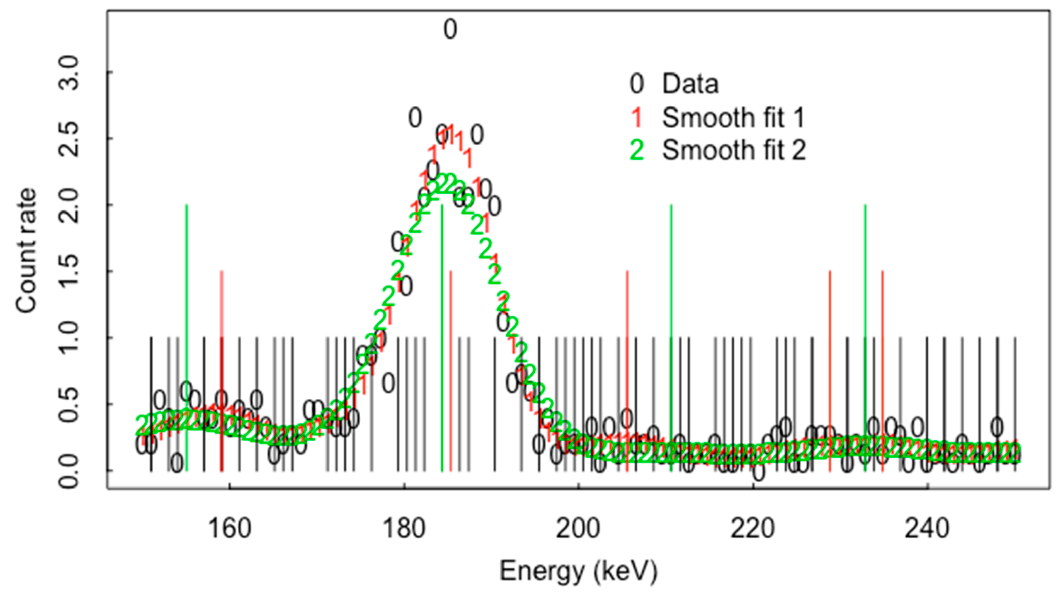
Figure 4. Raw data, smooth fit 1 and smooth fit 2 for U-235 spectrum.